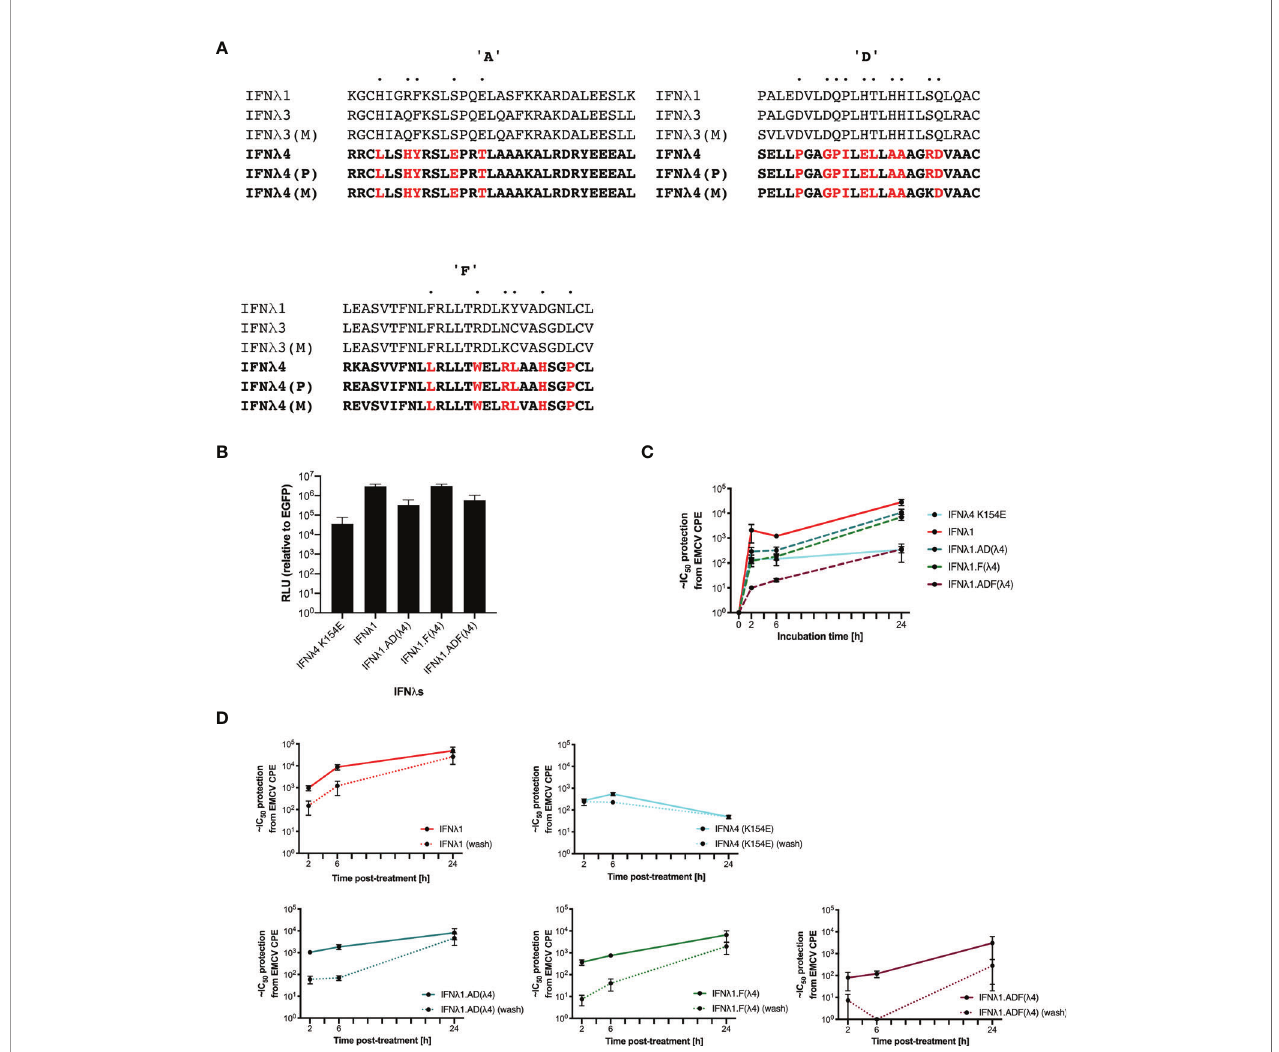
FIGURE 6 | IFN l 1 receptor-interacting interface mutants retain their kinetics. IFN l 1/4 chimeras were generated based on critical differences in helices (A, D, F) identi fi ed by alignment and comparative approaches. Speci fi c positions in helices only were modi fi ed to those found in IFN l 4 (red) (A) . Relative levels of IFN l s in supernatant by HiBiT assay following transfection of expression plasmids into HEK-293T cells measured at 48 h after transfection (B) . Effect of incubation time (2, 6, or 24 h) (C) and washing (2, 6, or 24 h, washed as hashed lines) (D) of antiviral activity in HepaRG cells against EMCV was calculated as outlined previously. Hatched line indicates limit of detection of that experiment. Error bars represent the mean ± SEM from two to four biological replicates. Data for Panel (C) was generated using independent protein batches as Panel (D)